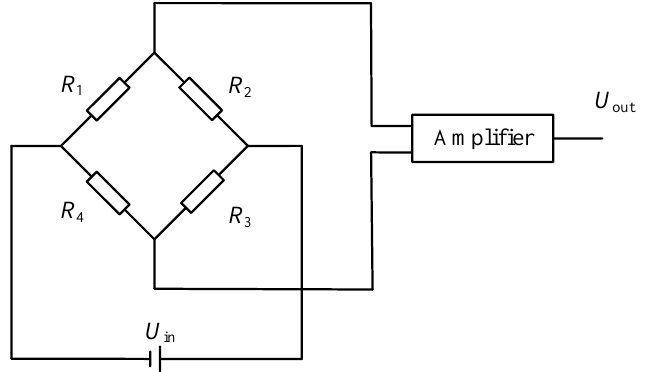
Figure 3. Diagram of the Wheatstone bridge circuit.